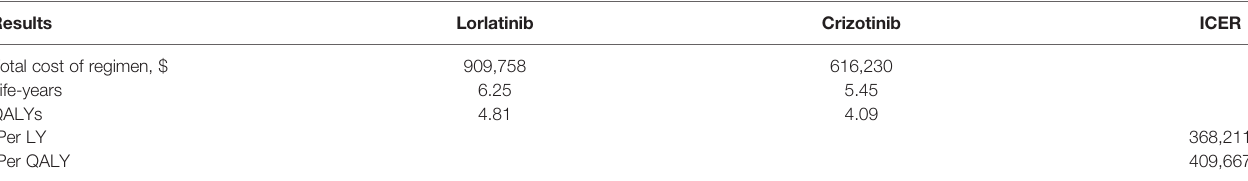
TABLE 2 | Summary base case